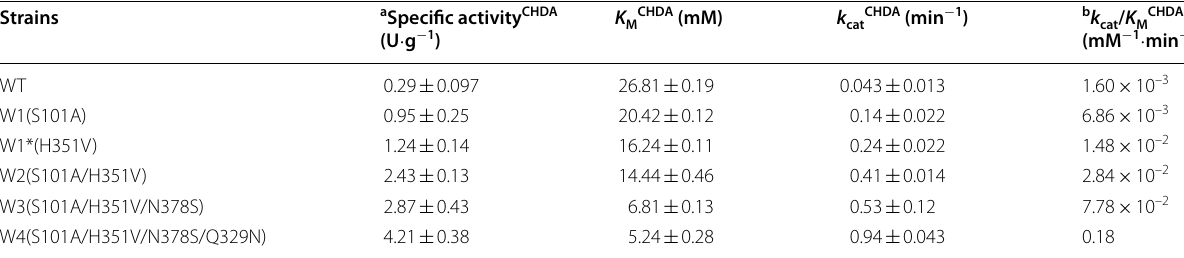
Table 1 Kinetic constants of Ac CO and its variants in producting CHDA Strains